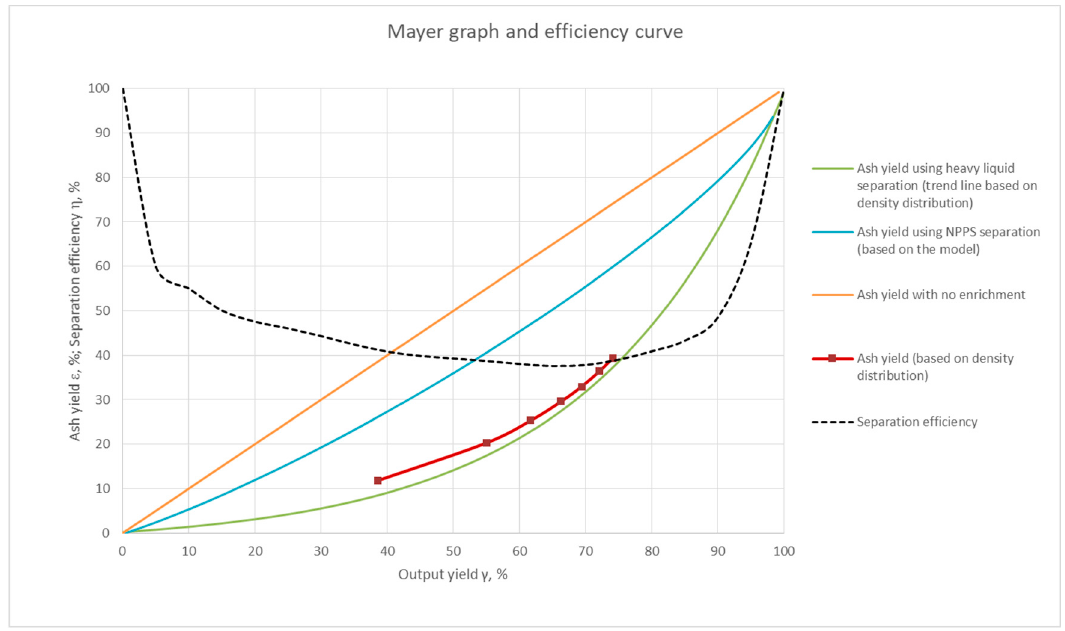
Figure A6. Assessment of the efficiency of coal separation with use of the NPPS in comparison to wet methods—feed material no. 4 in grain size class 0–20 mm.